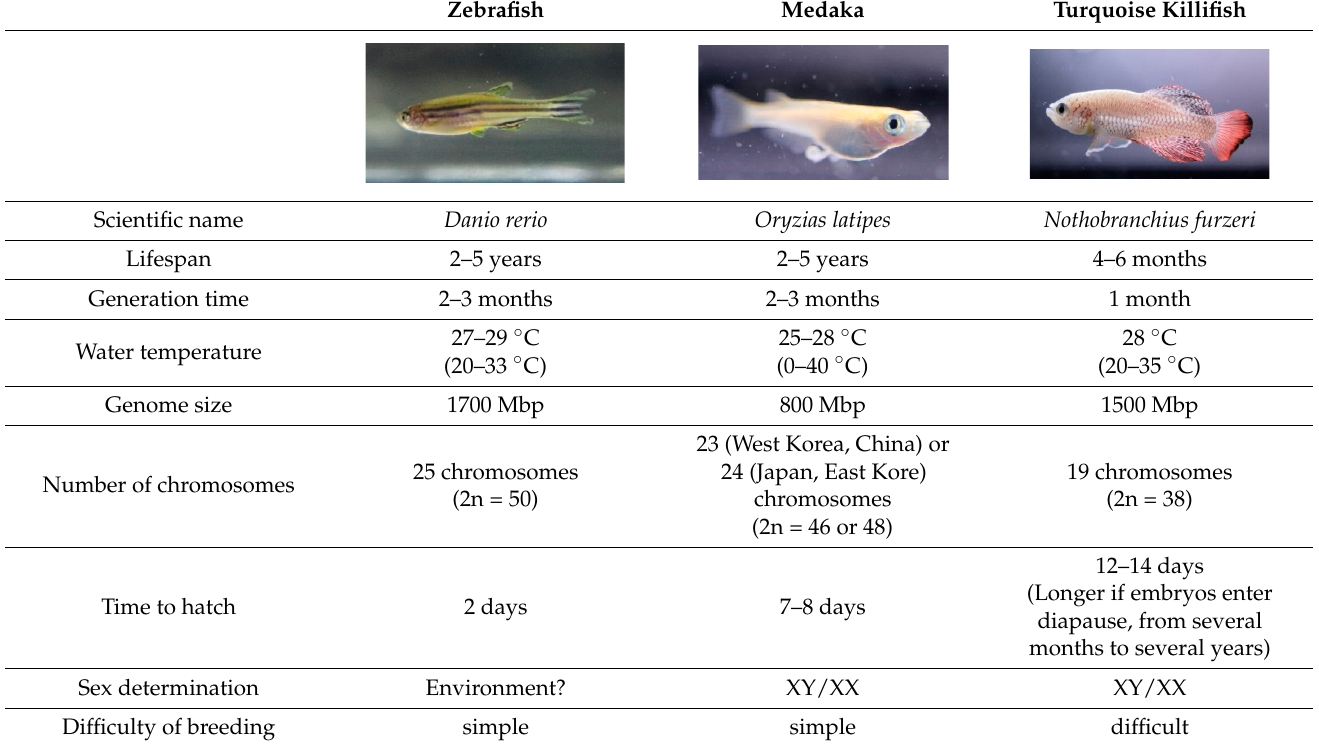
Table 1. Characteristics of zebrafish, medaka and turquoise killifish.